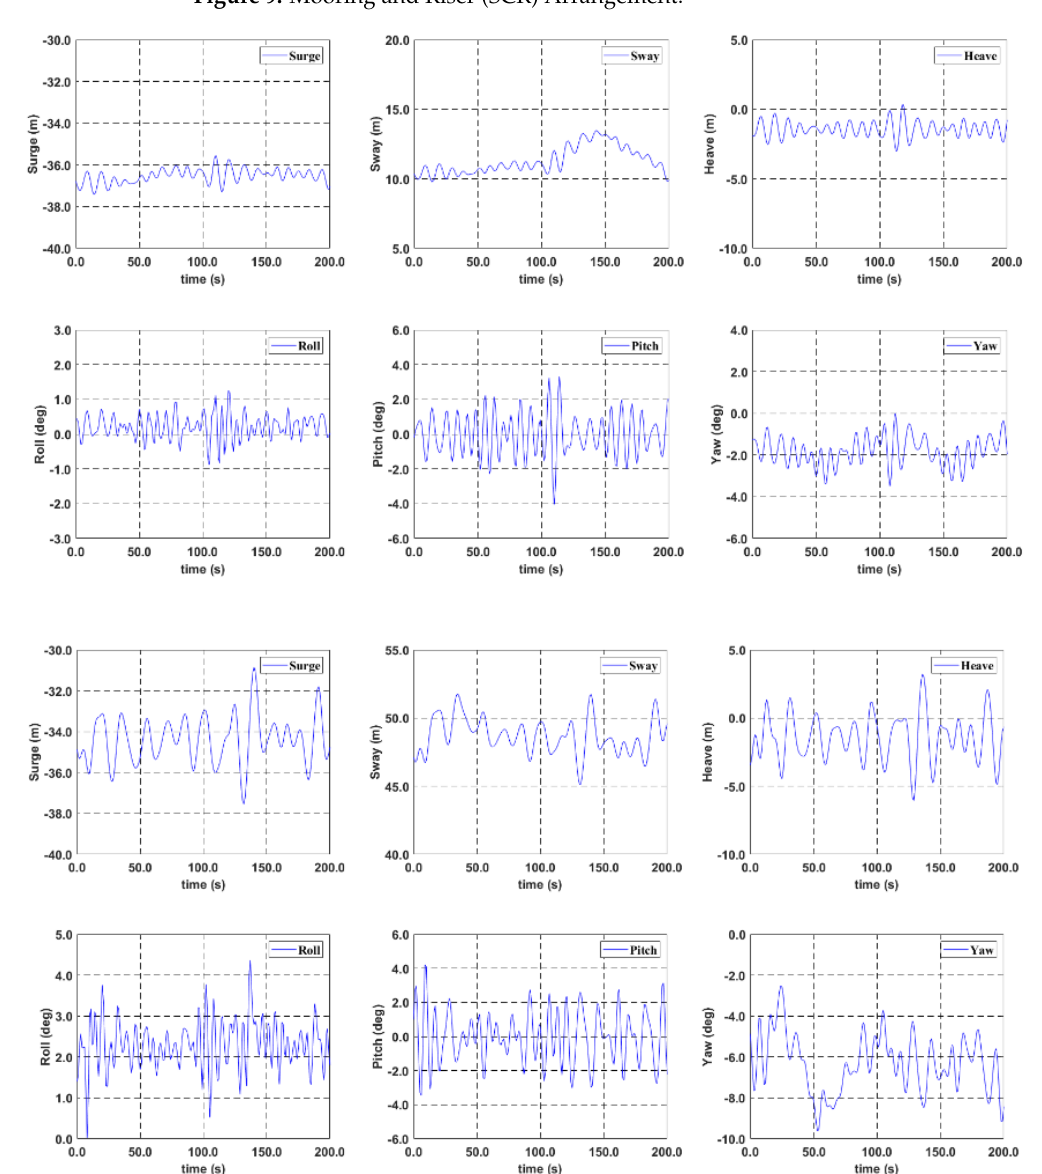
Figure 9. Mooring and Riser (SCR) Arrangement.